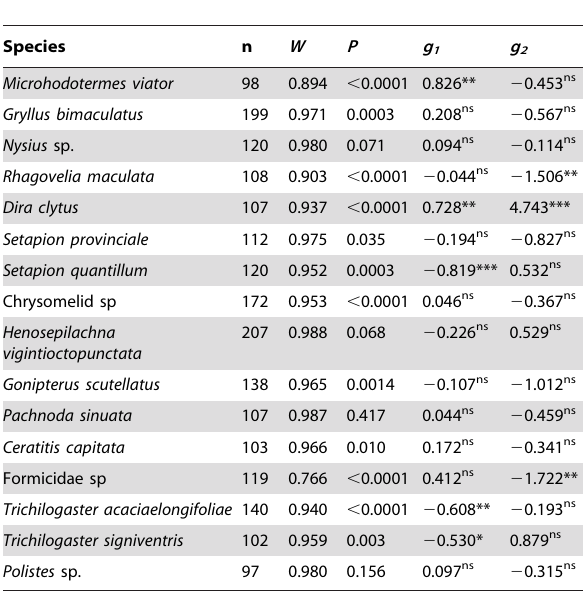
Table 4. Outcome of the assessment of deviation from normality (Shapiro-Wilks W statistic) and the degree of skewness ( g 1 ) and kurtosis ( g 2 ) for the untransformed body size frequency distributions based on the linear measures made for all 16 insect species